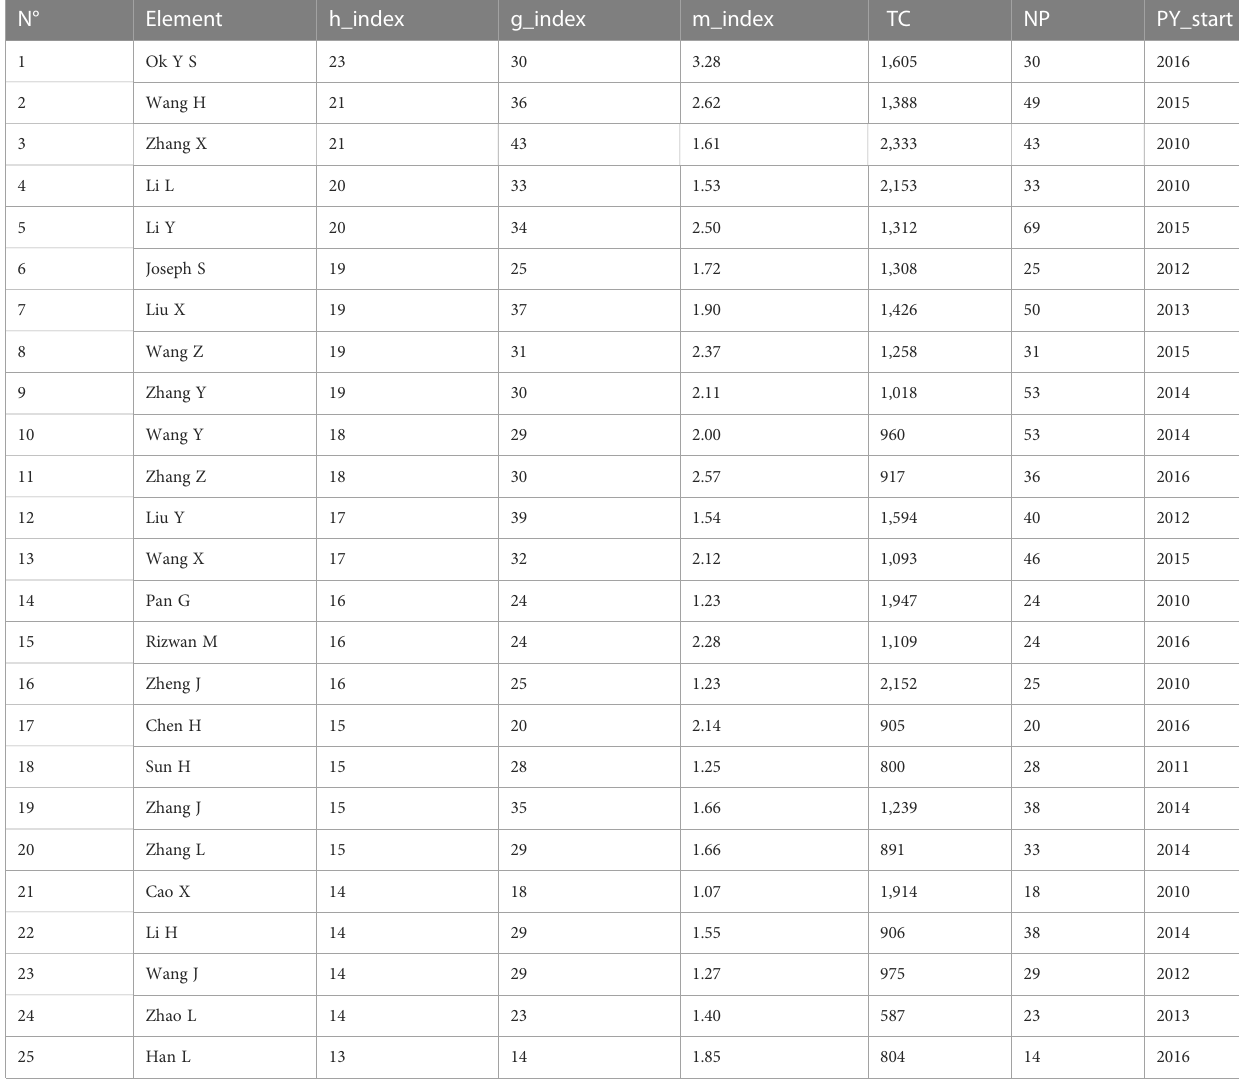
TABLE 3 Top twenty- fi ve most in fl uential authors ’ publications on biochar-based smart fertilizers. N°